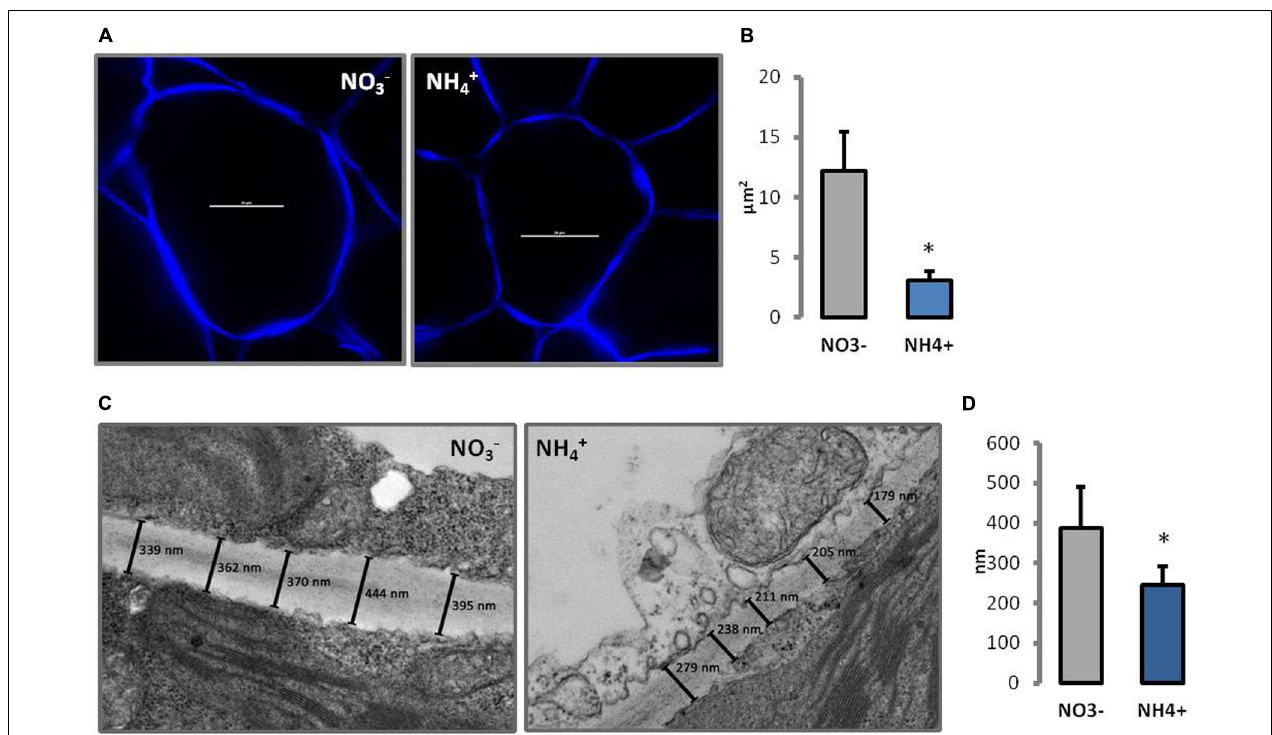
FIGURE 2 | Cell wall morphology of leaf mesophyll cells of plants growing on NH 4 + and NO 3 − (control) as the only N source. (A) Cell wall visualization of individual palisade cells by Calcofluor White staining in CLSM (scale bar = 20 µ m), and (B) cell size measurement from six independent biological replicates. (C) Ultrastructure of cell walls. The lines indicate the measured points in the cell wall. A representative of the 20 independent images that were used for measuring cell wall thickness (D) .